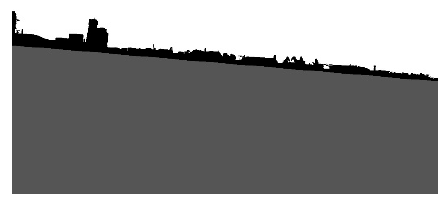
Figure 8. Results of the progressive segmentation. A pseudocode of the progressive land segmentation algorithm is presented in Figure